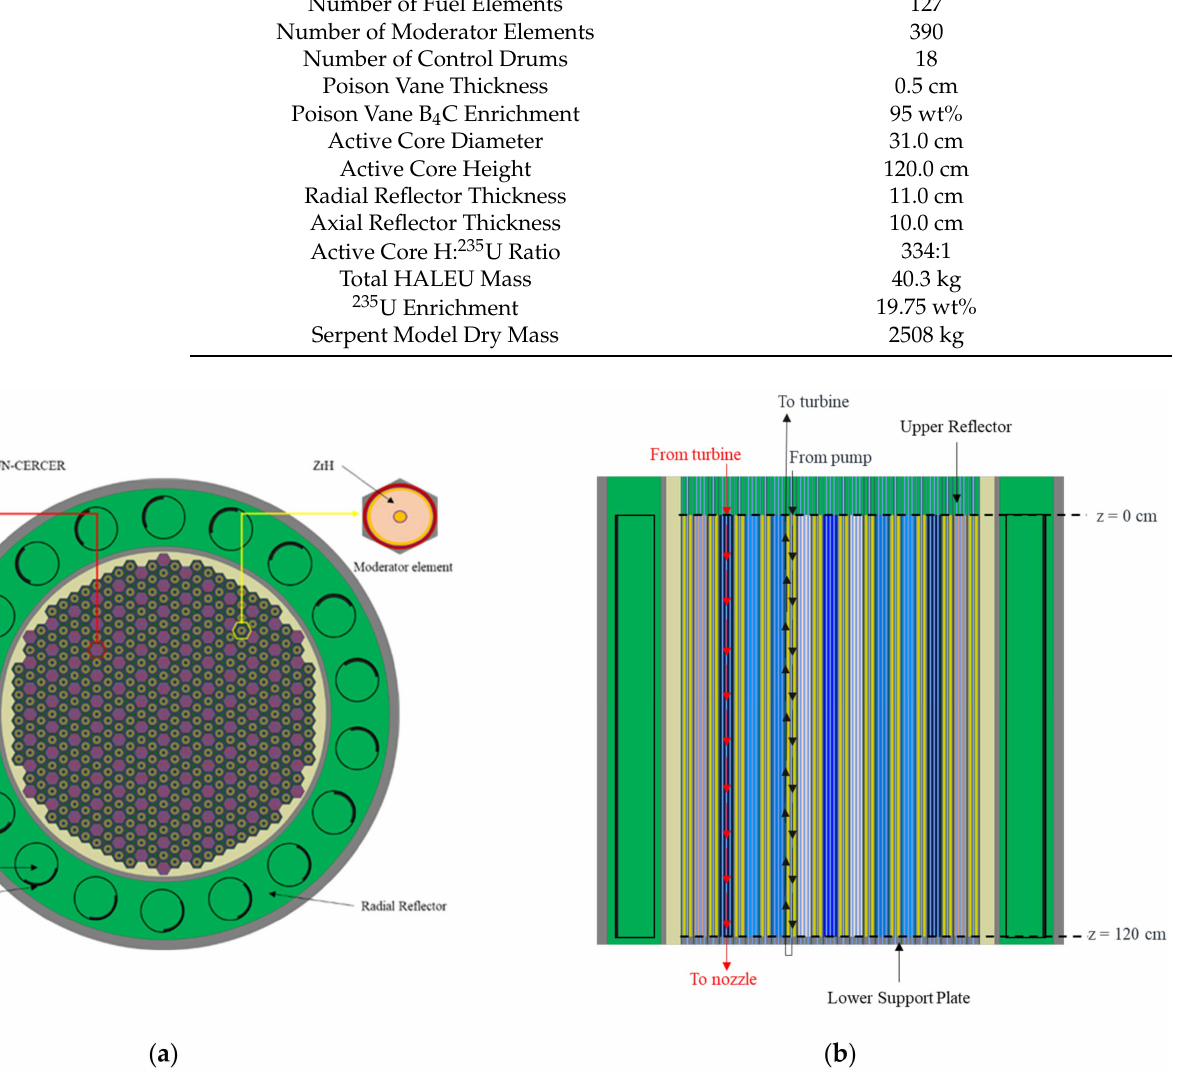
Figure 4. Reactor design: ( a ) radial core cross-section; ( b ) axial core